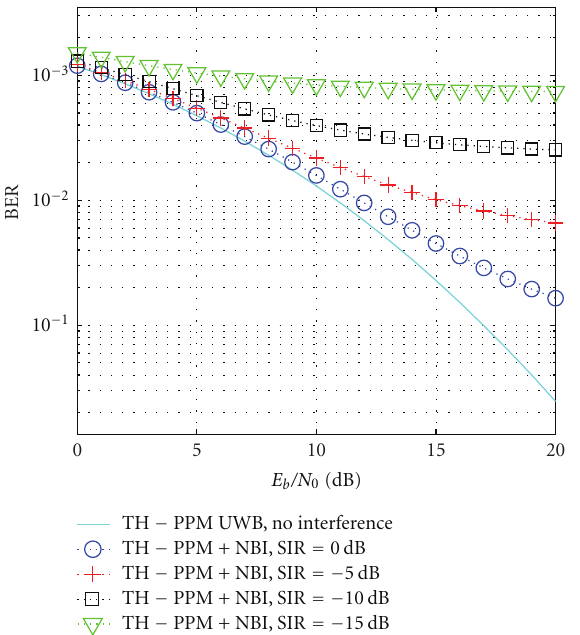
Figure 3: TH-PPM UWB performance in the presence of NBI.